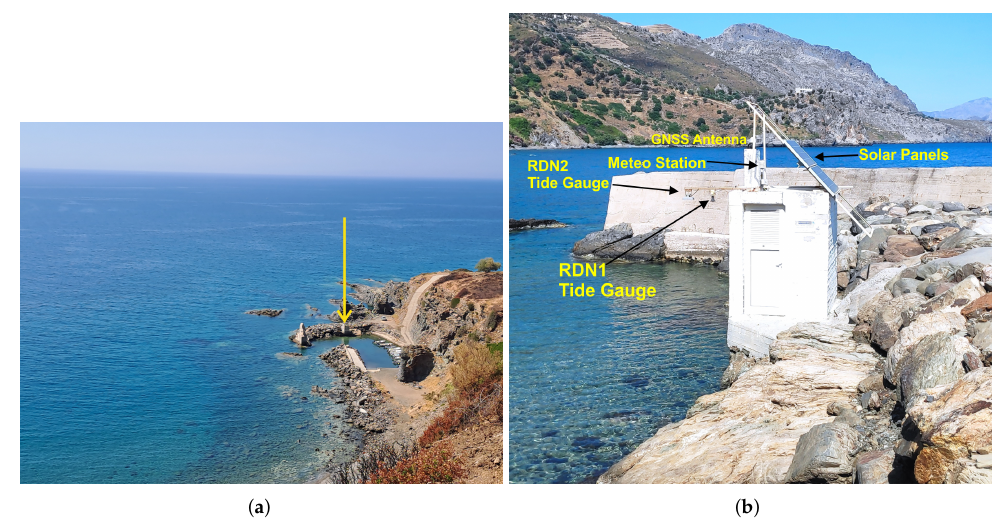
Figure 3. The CRS1 Cal/Val site infrastructure and instrumentation setup.